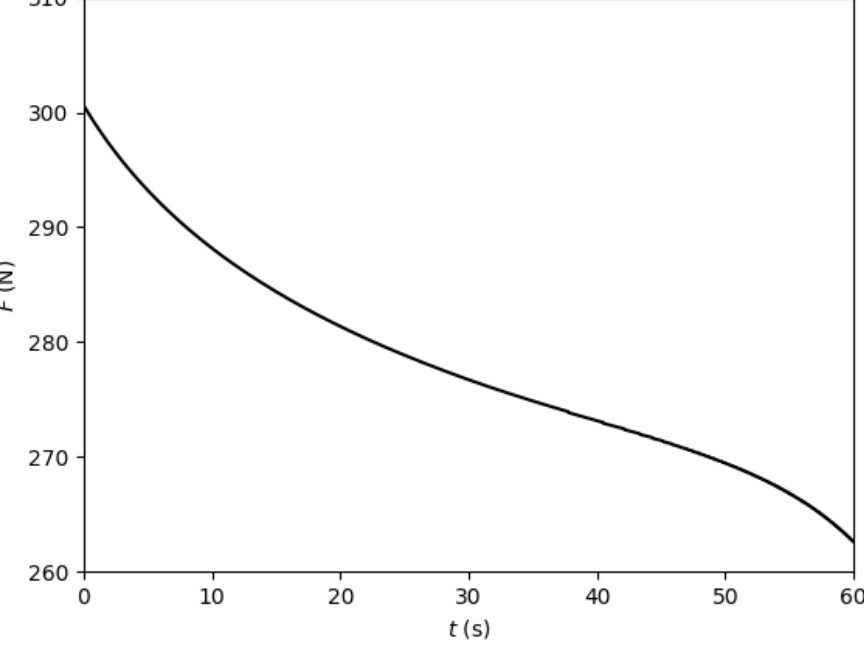
Figure 15. Thrust profile without feedback control.